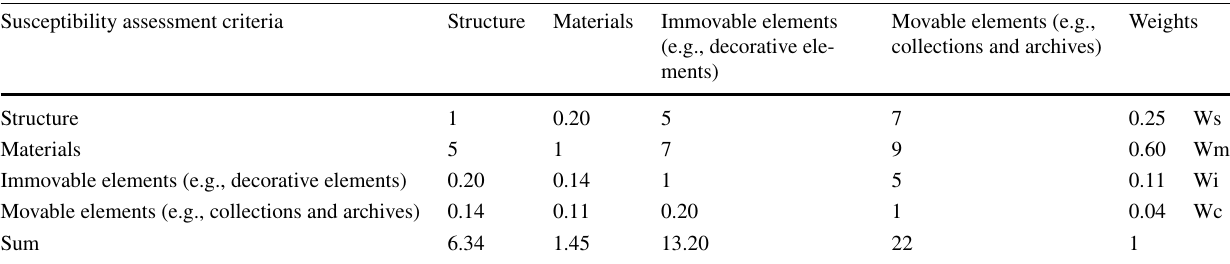
Ws weight of structure, Wm weight of materials, Wi weight of immovable elements, Wc weight of